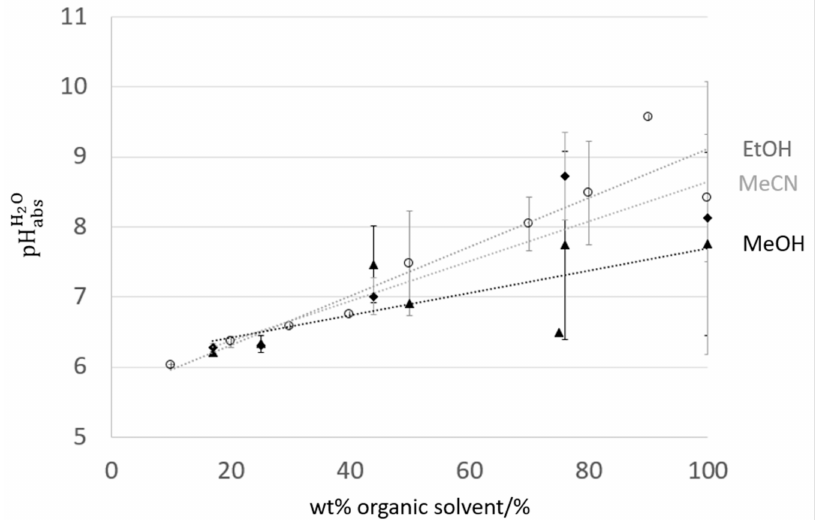
Figure 2. pH H 2 O values for mixtures of ethanol (EtOH, ), acetonitrile (MeCN, (cid:117) ), and methanol abs (cid:35) (MeOH, (cid:78) ) with water, measured at institutes using SCGEs. Error bars are calculated using Equation (1), and represent the distribution of values measured at different